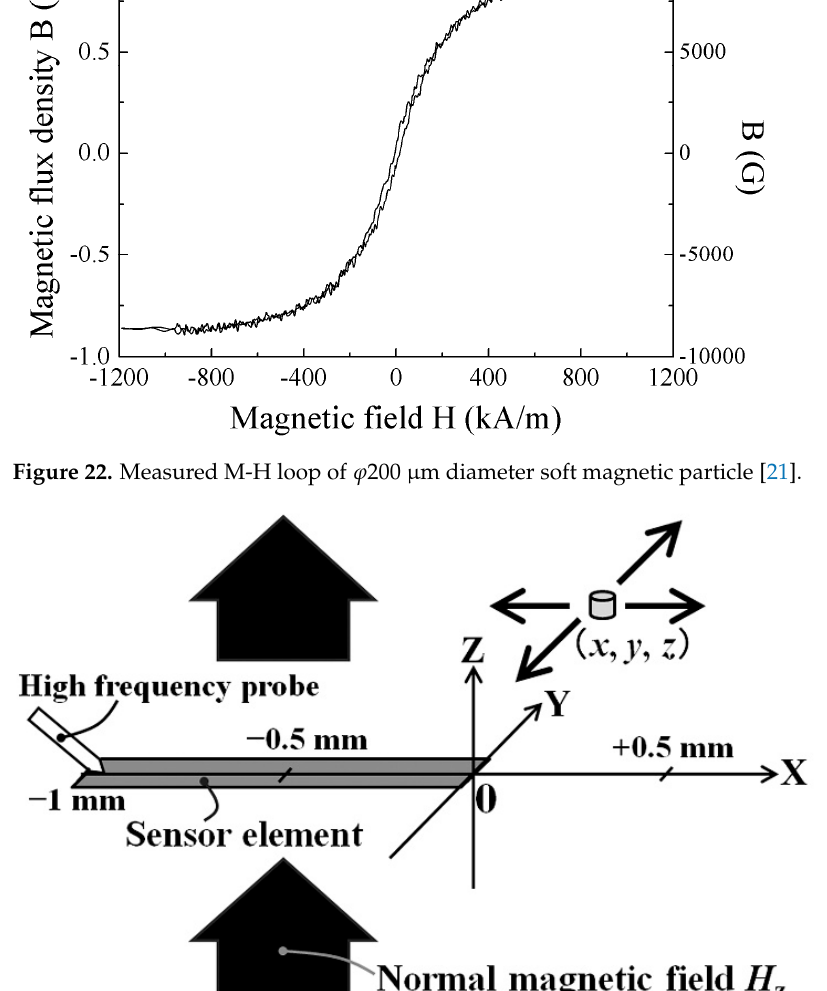
Figure 24. Result of measurement of scanned magnetic small particle along sensor longitudinal di- rection [21].